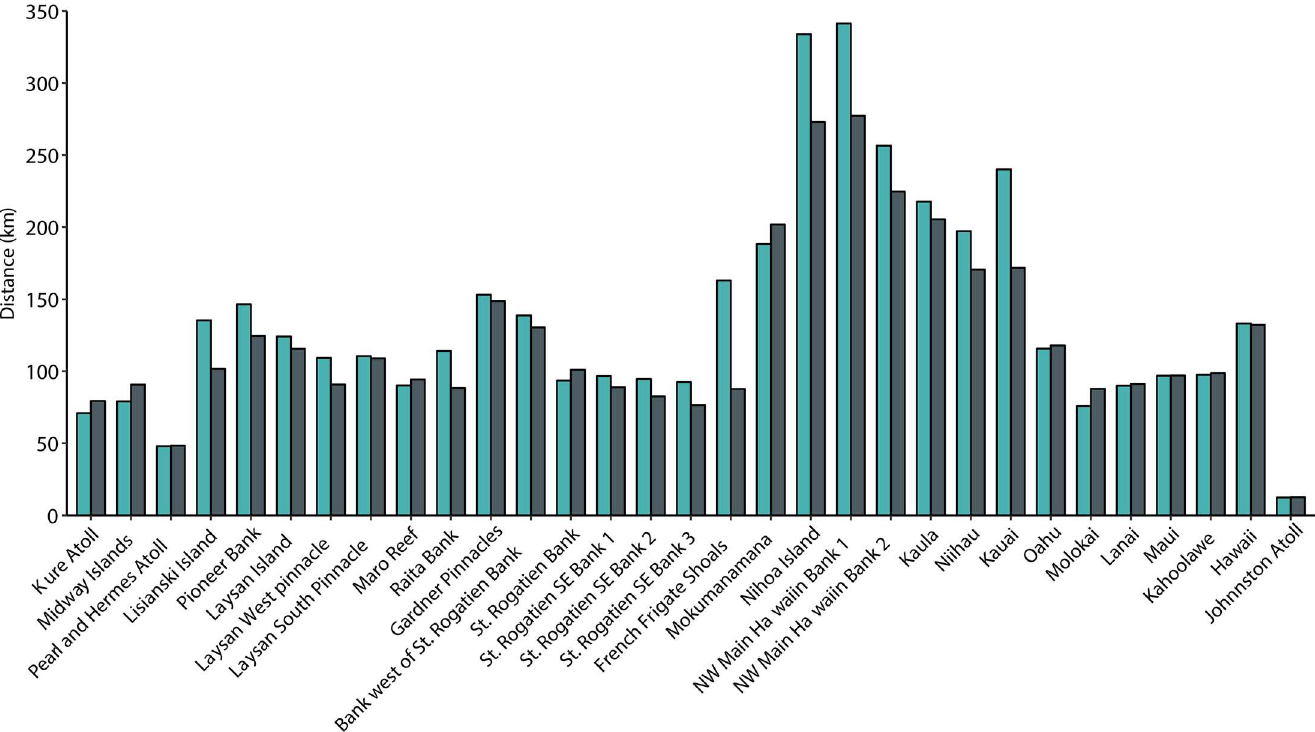
Fig 6. Island specific mean particle dispersal distances from the source island. Green color denotesparticles releasedduringMay-June and gray denotesdistances for year-roundrelease.